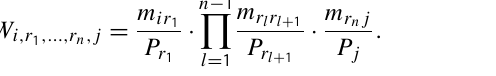
m 14 /P 4 and the contribution · m 13 /P 3 m 14 /P 4 . The legend is the · ·